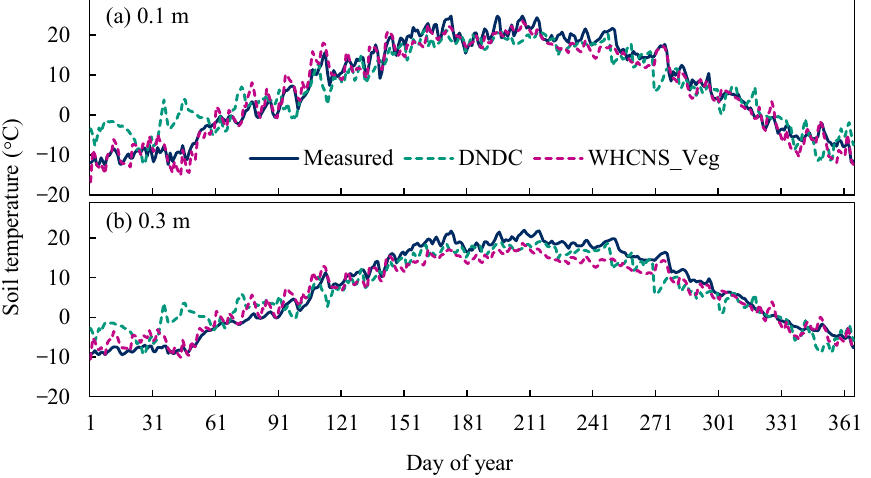
Figure 3. Daily soil temperature was compared to measurements at ( a ) 0.1 m and ( b ) 0.3 m soil depths using the DNDC and WHCNS_Veg models in Wuchuan, China. Table 5. Statistical calibration between the simulated and measured soil temperature, soil moisture and soil inorganic nitrogen using the DNDC and WHCNS_Veg models in Wuchuan, China.